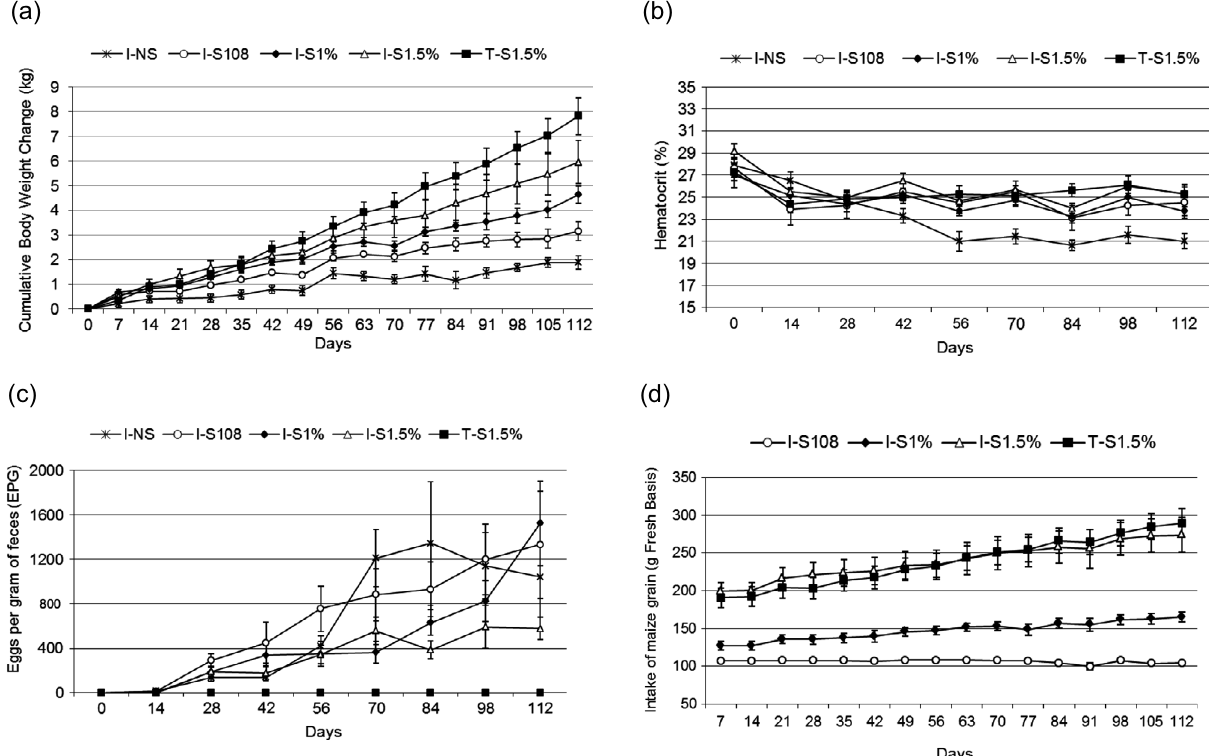
Figure 1. Effect of different levels of maize supplementation on the cumulative bodyweight change (kg) (a), hematocrit (%) (b), nematode eggs per gram of feces (c), and maize intake (g fresh basis) (d) in browsing Criollo kids naturally infected with gastrointestinal nematodes during the rainy season. I-S108 = infected and supplemented with 108 g maize grain. I-S1% = infected and supplemented with maize grain at 1% LW. I-S1.5% = infected and supplemented with maize grain at 1.5% LW. NI-S1.5% = no infected (moxidectin treatment) and supplemented with maize grain at 1.5% LW. I-NS = infected non supplemented Table 3. Mean (±SEM) of the cumulative bodyweight change (kg), daily bodyweight change (g), total maize intake (kg), hematocrit (%), hemoglobin (g/dl) and eggs per gram of feces (EPG) of browsing kids supplemented with different levels of maize grain during the rainy season.